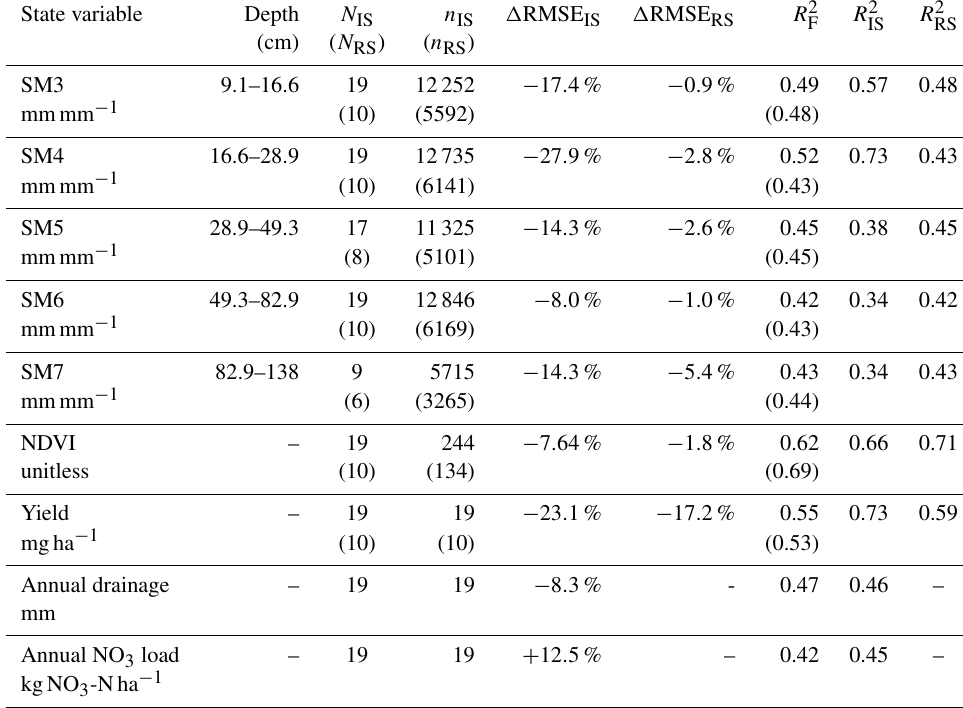
Table 3. Summary statistics to quantify the impact of in situ SDA (IS) and RS-SDA (RS) on forecast accuracy of APSIM state variables. The “ N IS ” column indicates the number of site years with available data for each state variable and each run, and the “ n IS ” column indicates the total number of observations across site years for each run. A subscript F denotes a value computed for the free model estimates, a subscript IS denotes a value for the in situ SDA estimates, and a subscript RS denotes a value for RS-SDA runs. The median change ( D ) in RMSE was computed for both runs. Two values for R2F are given for the different data subsets demonstrated in the “ N ” and “ n ” columns. State variable N